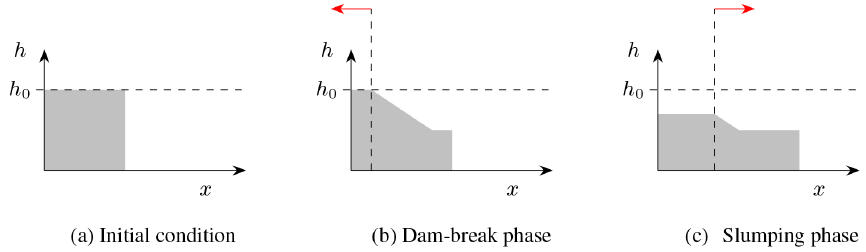
Figure 2. Schematic diagram of the lock-release static initial condition (a) and the following dam-break (b) and slumping (c) phases with Figure2. Schematicdiagramofthelock-releasestaticinitialcondition(a)andthefollowingdam-break(b)and the shock wave propagation direction indicated by ( slumping(c)phaseswithshockwavepropagationdirectionindicted( ).